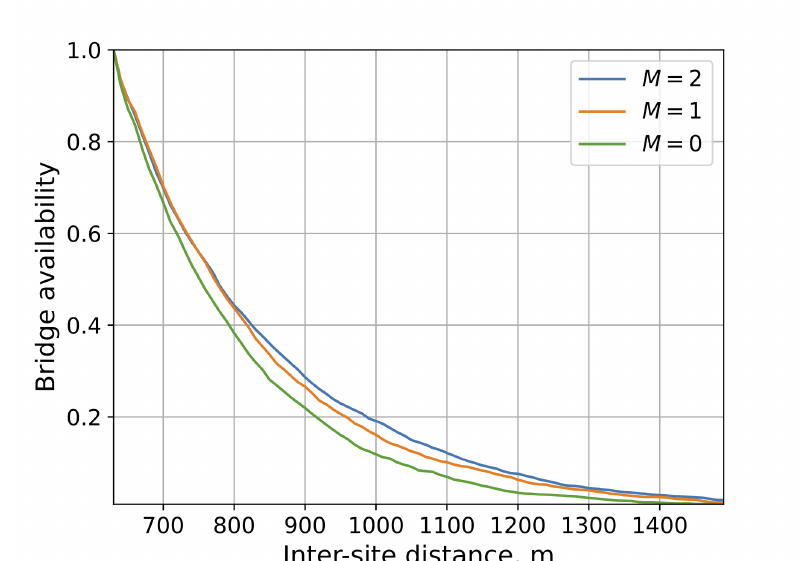
Figure 7. Bridge availability as a function of the number of traffic